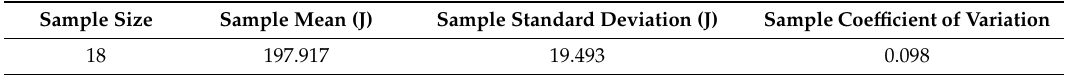
Table 10. Sample statistical data of transferred energy measured by the pin-rod